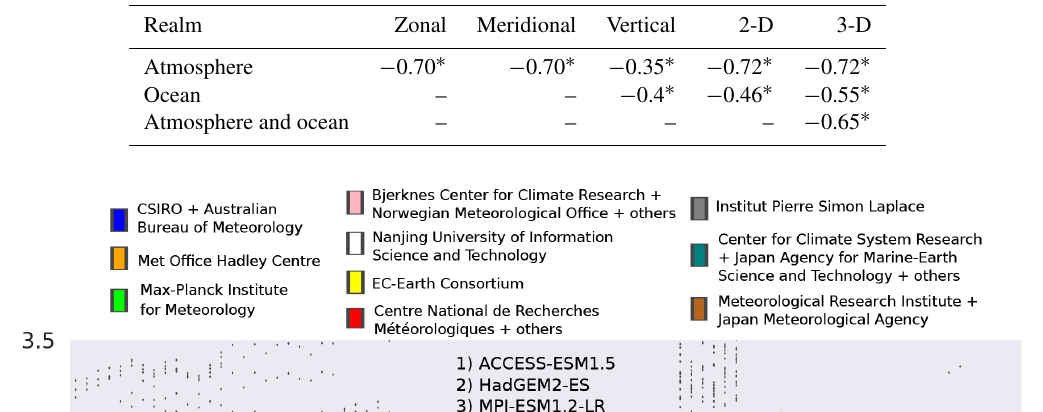
Table 2. Rank correlation coefficients between the median MAE values of the 56 models and various resolution parameters of the atmosphere or/and ocean component models. A significant relationship is indicated by an asterisk ( α = 0.01, two-tailed t test, H 0 = zero correlation). See text for more details.